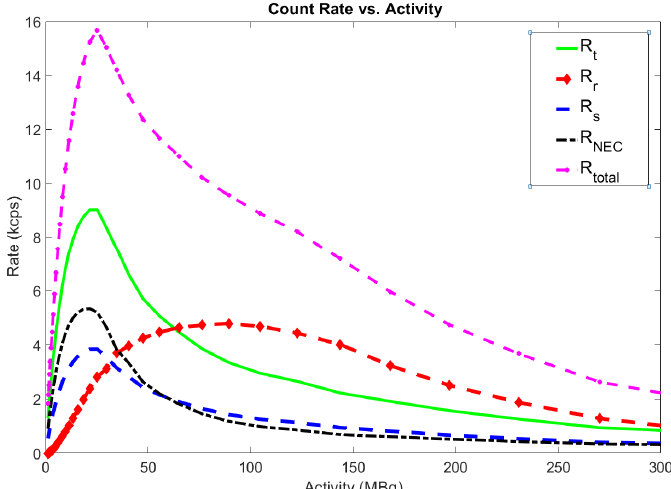
Figure 6. Counting rate performance versus source activity. R t = true rate; R r = random rate; R s = scatter rate; R NEC = noise equivalent count rate; R tot = total count rate.